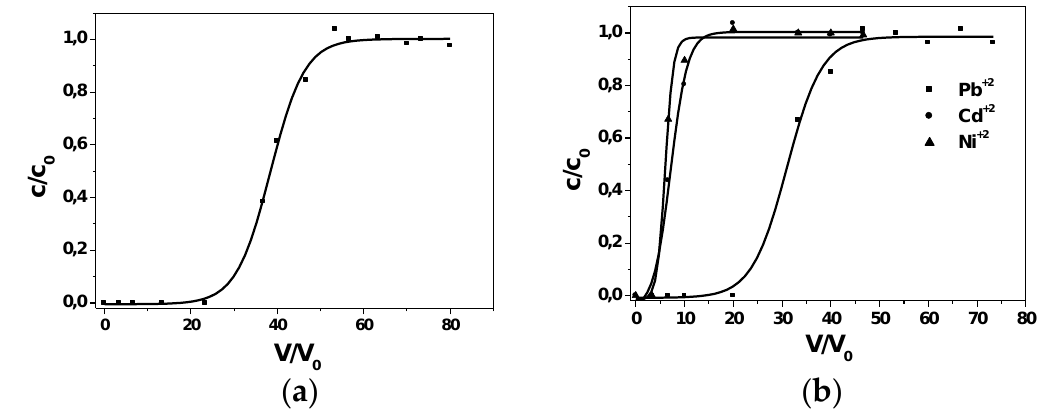
Figure 4. Breakthrough curves in de-mineralized water for ( a ) lead ions and ( b ) solution of lead, cadmium and nickel ions on perlite (1–2 mm particle size, 0.3 L/h, 15 mg(Me +2 )/dm 3 , pH = 6, T = 298